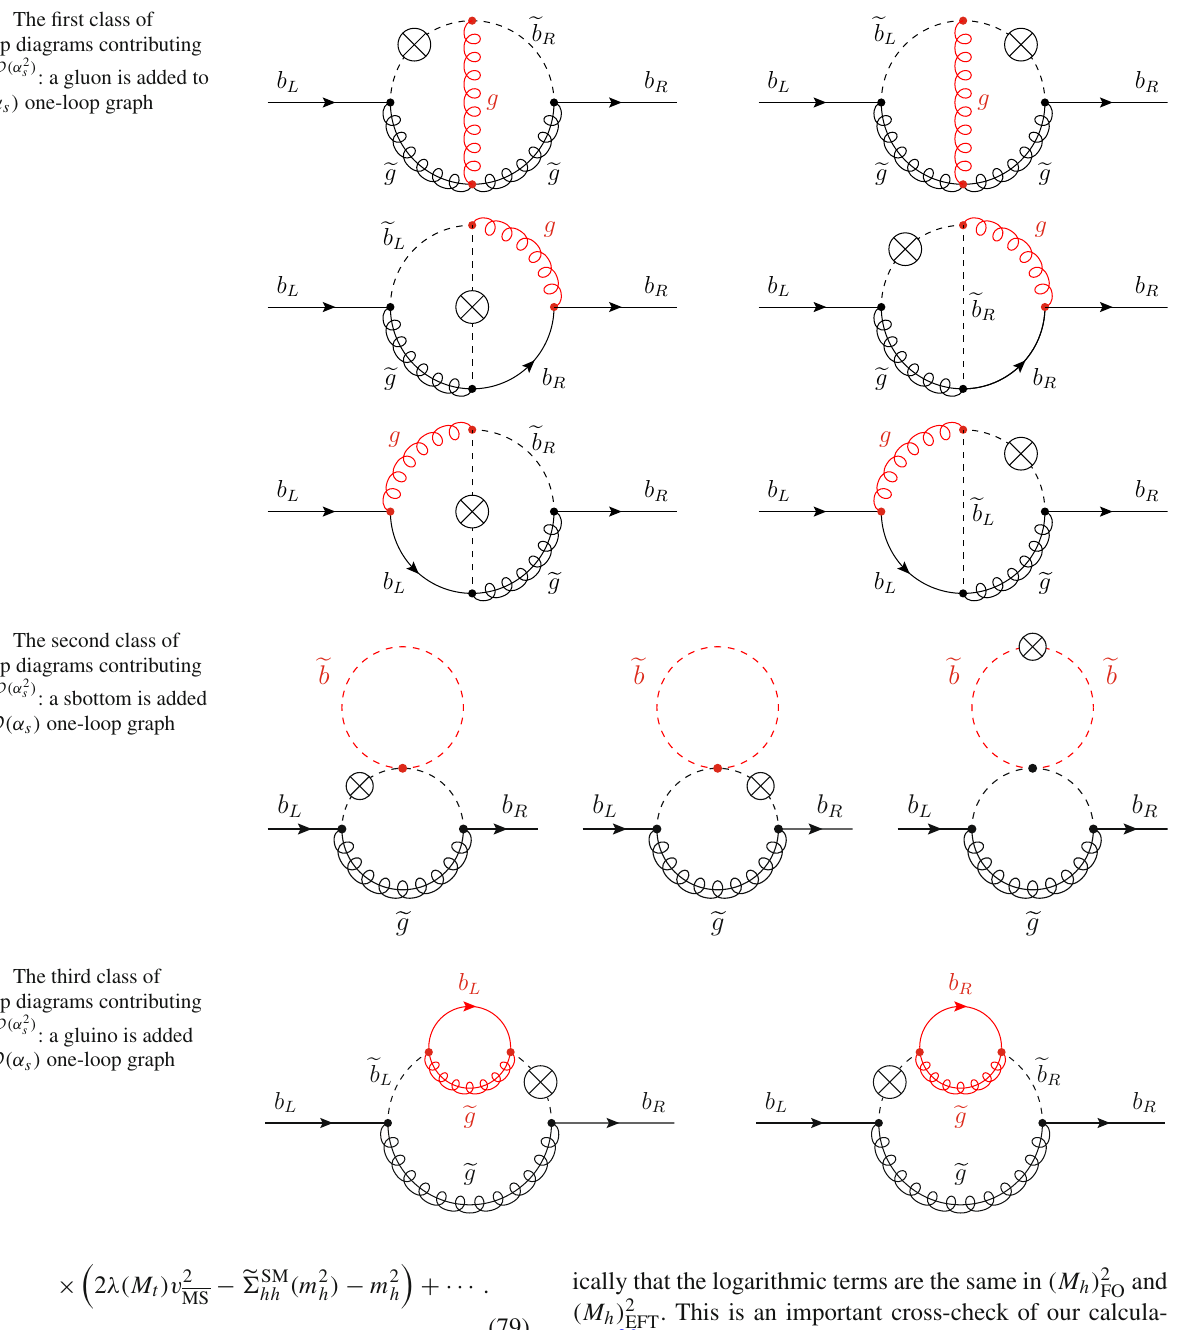
Fig. 12 The second class of two-loop diagrams contributing